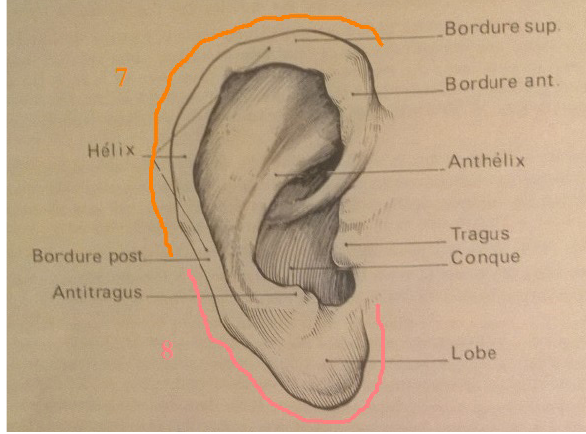
Figure 5. Points of variation for the ear (from Pales,